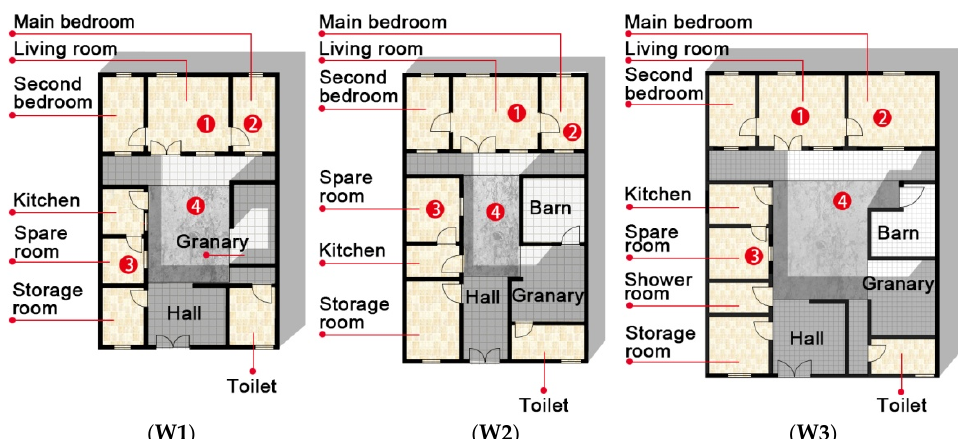
Figure 13. Arrangement of the instruments during winter.